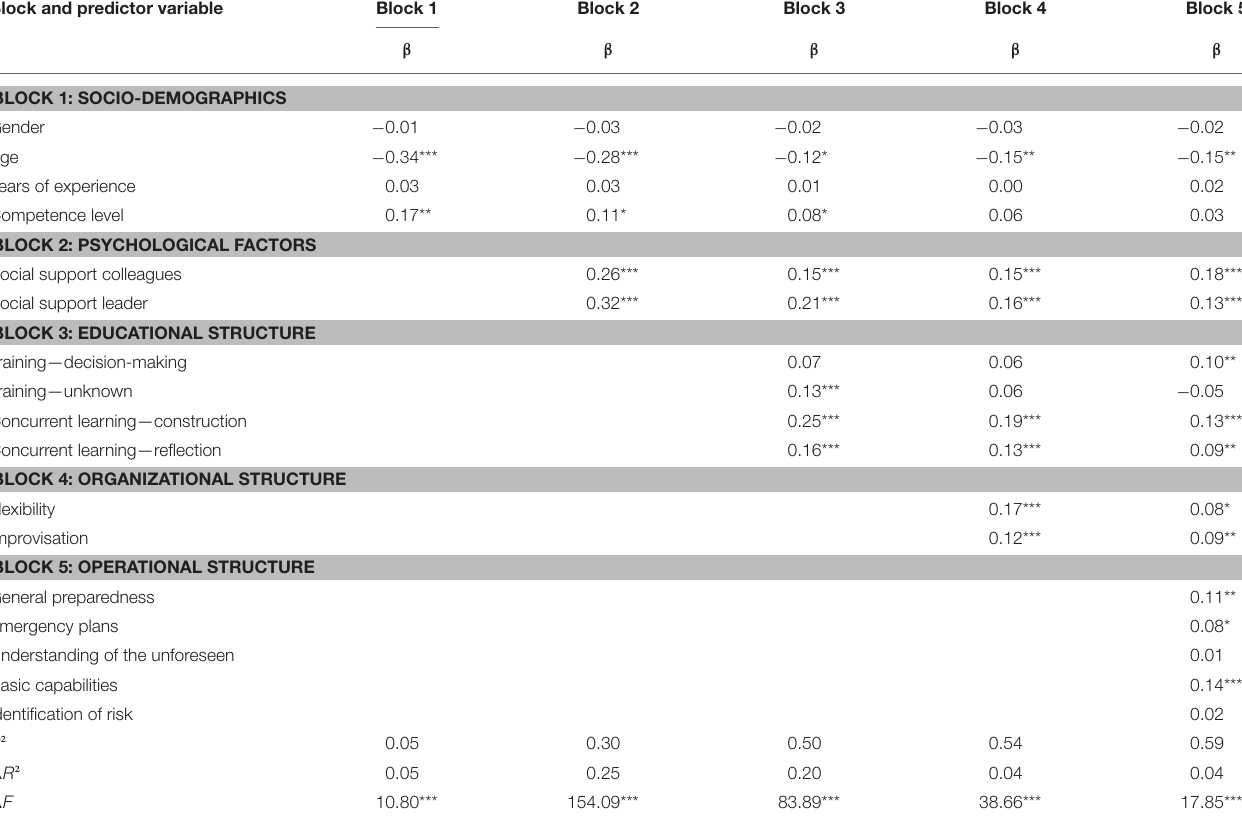
TABLE 4 | Summary of hierarchical multiple regression analysis with interaction as criterion. Block and predictor